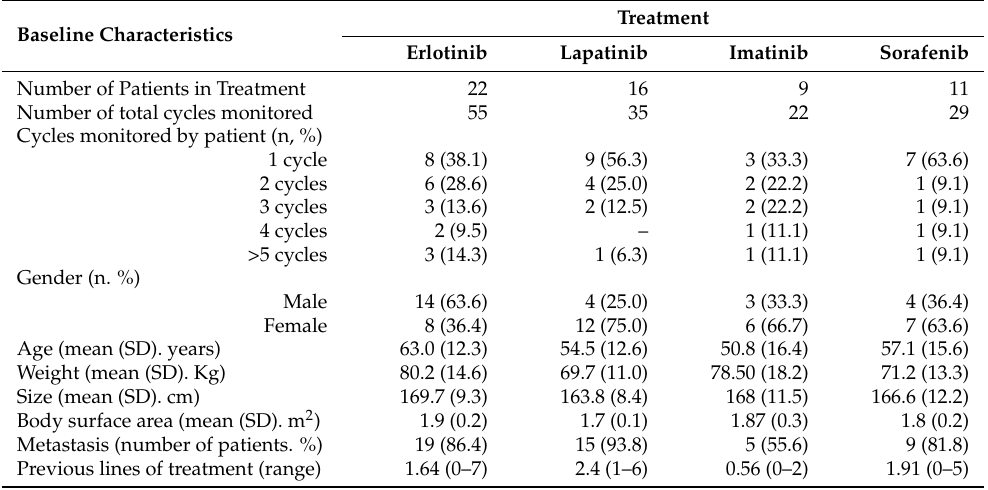
Table 2. Baseline